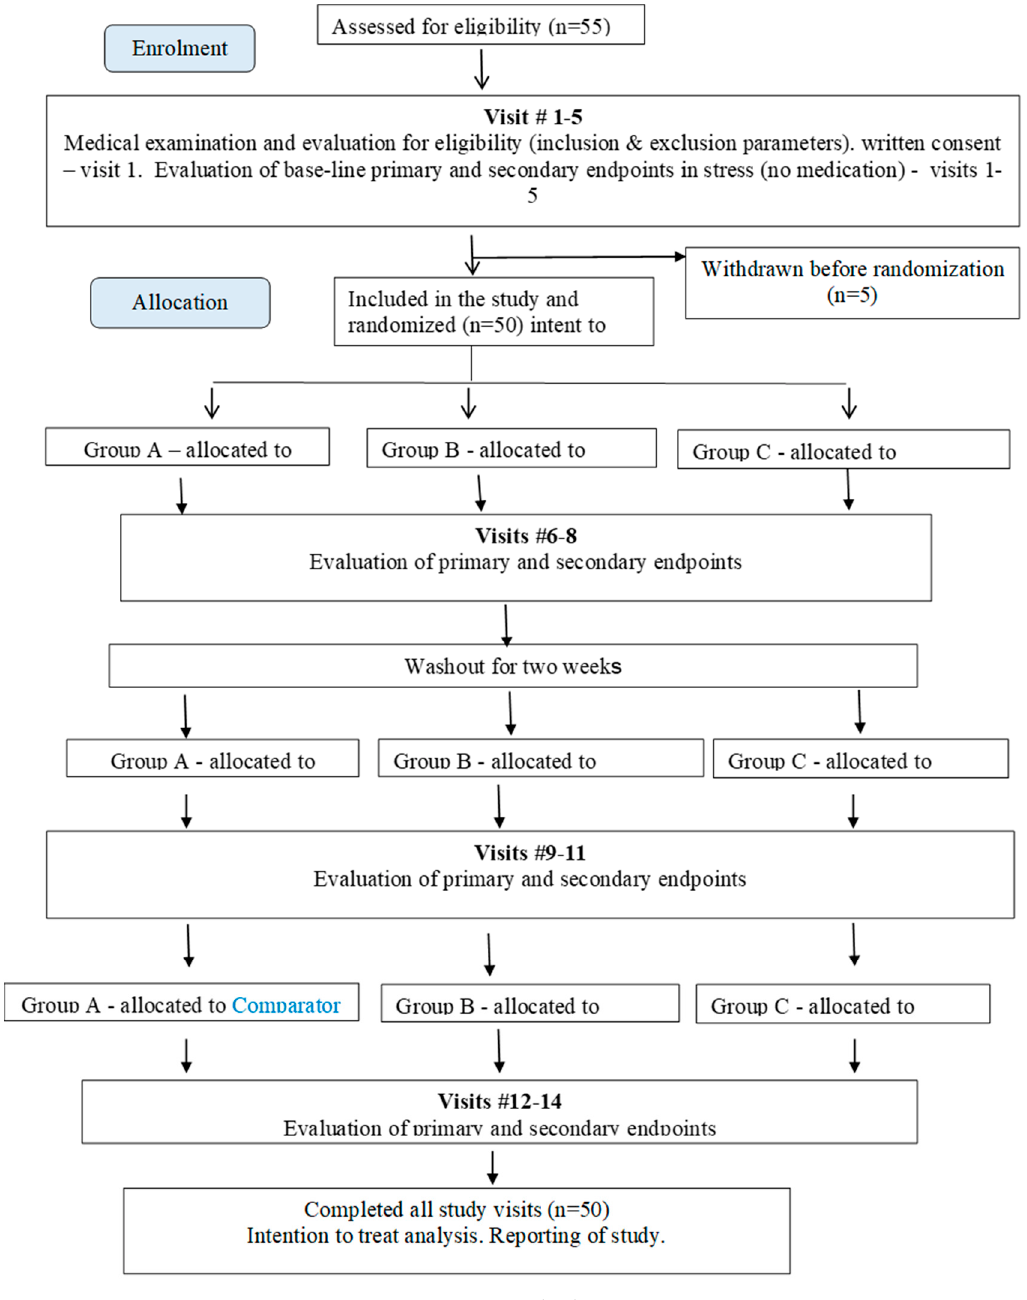
Figure A1. Study design.